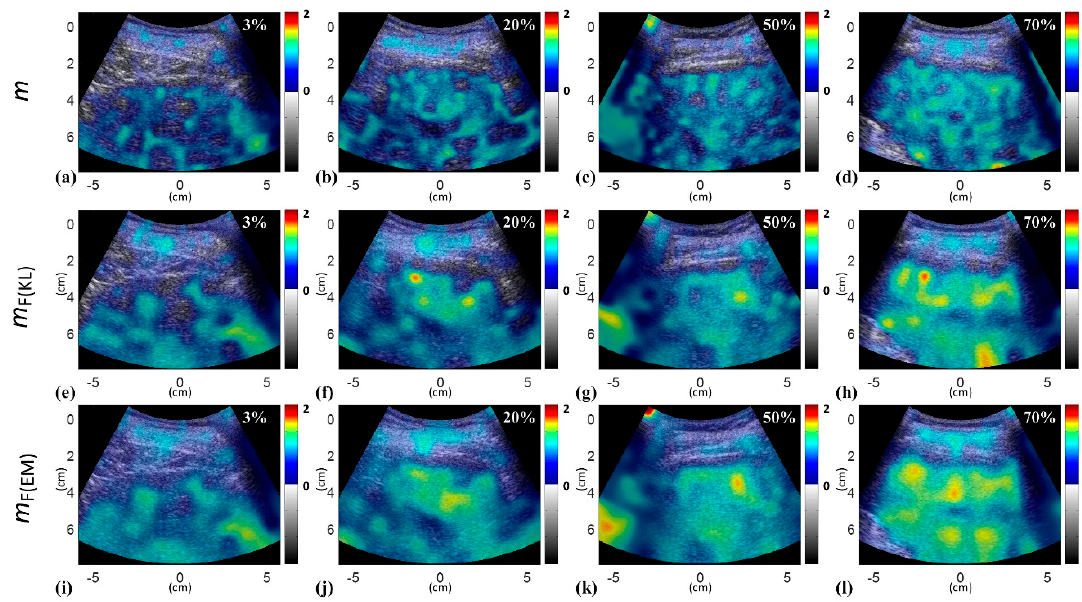
Figure 8. Ultrasound parametric imaging constructed using the m ( a – d ), m F(KL) ( e – h ), and m F(EM) ( i – l ) parameters for different grades of hepatic steatosis. The formation of hepatic steatosis strengthened the image brightness in the Nakagami and the proposed DND imaging, representing increases in the parameters m , m F(KL) , and m F(EM) .